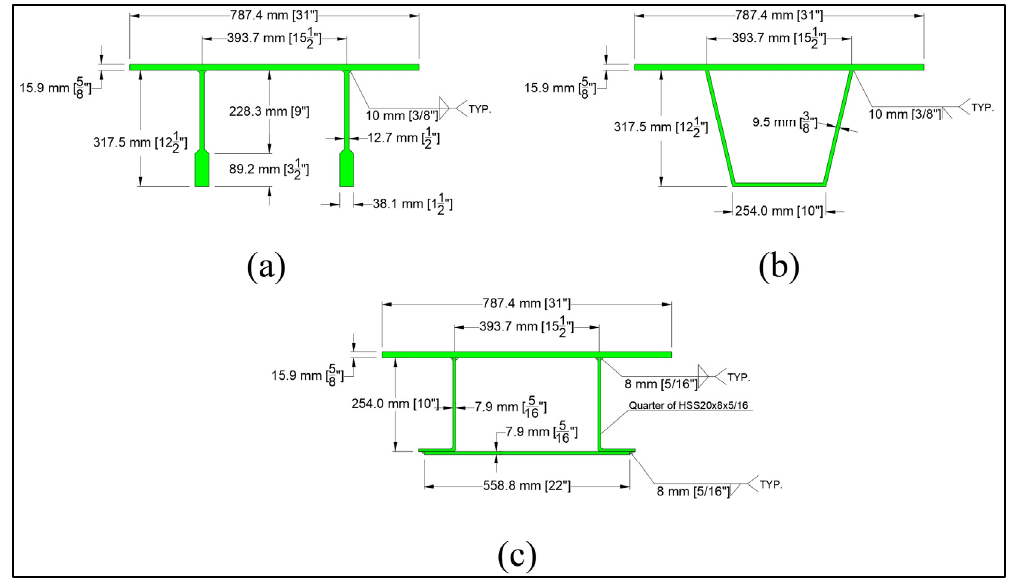
Figure 5. ( a ) Benjamin Franklin bulb section; ( b ) Typical trapezoidal section suggestion; ( c ) Built-up section suggestion.